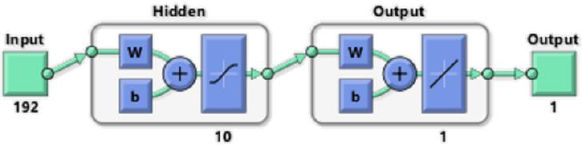
Figure 14. Structure of the selected multi-layer perceptron.